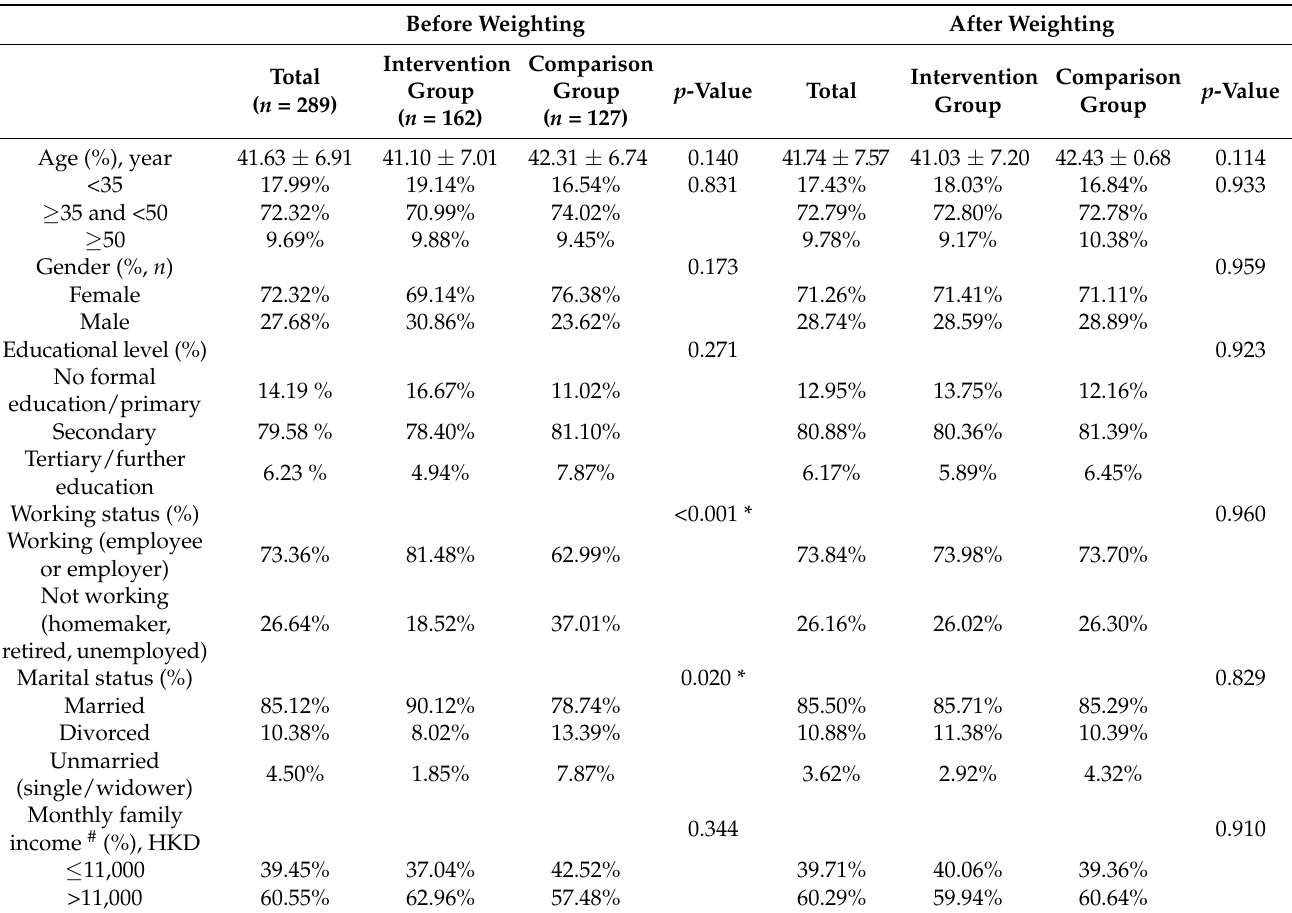
Table 1. Baseline characteristics before and after applying inverse probability weighting using propensity